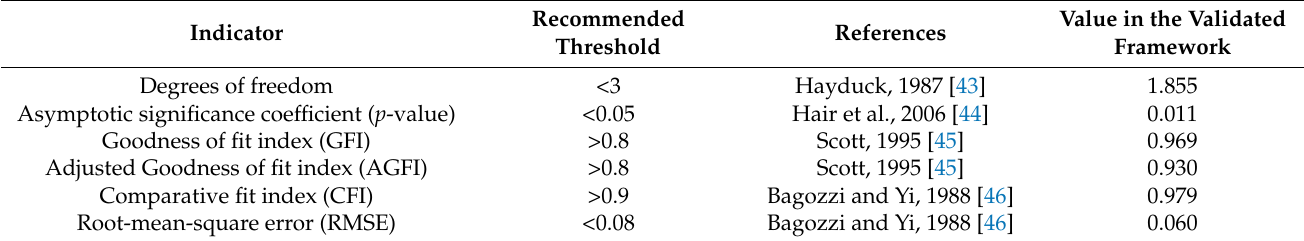
Table 4. Indicators related to fit